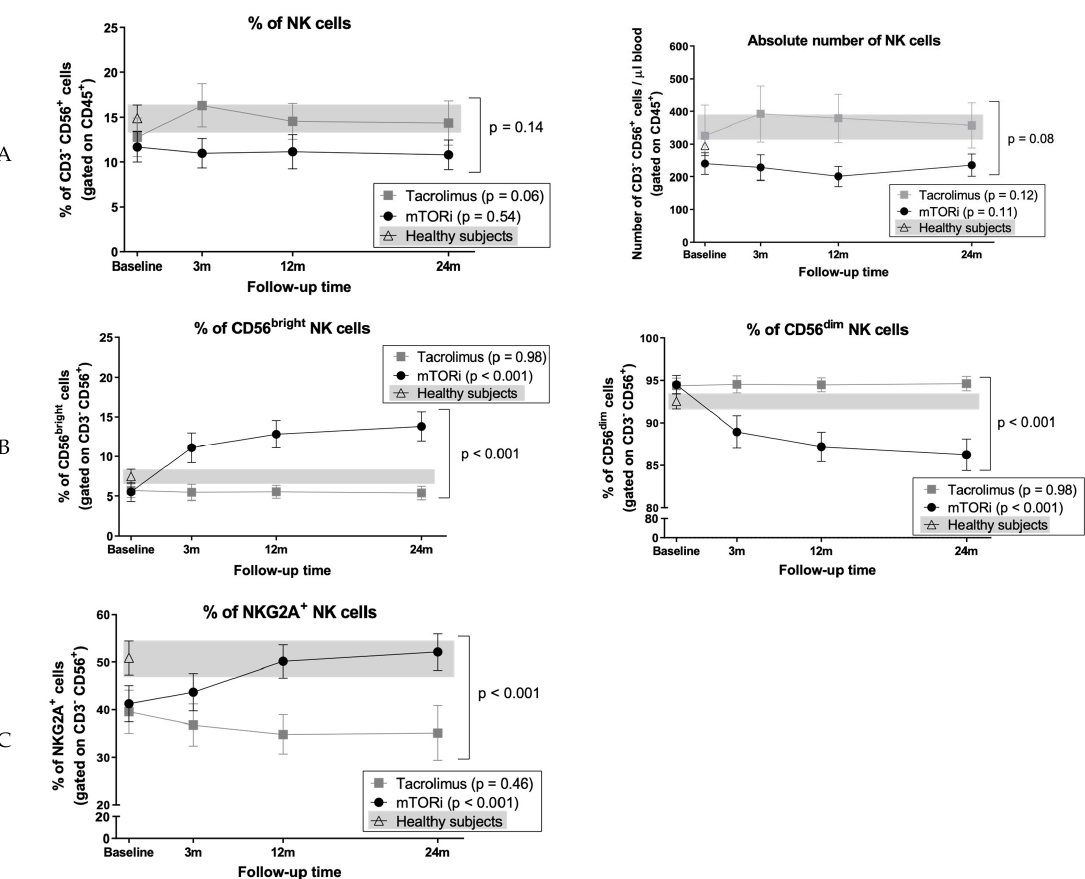
Figure 4. Evolution of Natural Killer (NK) cells after switching from tacrolimus to mTORi. Immunophenotyping of ( A ) total NK cells, ( B ) CD56 bright and CD56 dim NK cell subsets, and ( C ) NK cells expressing the CD94/NK group 2 member A (NKG2A) receptor. Patients before and after switching to mTORi are depicted with black dots, and patients maintaining tacrolimus are depicted with grey squares. HS data is depicted with white triangles, and the grey background corresponds to range. Plots show mean and SEM for each time point.